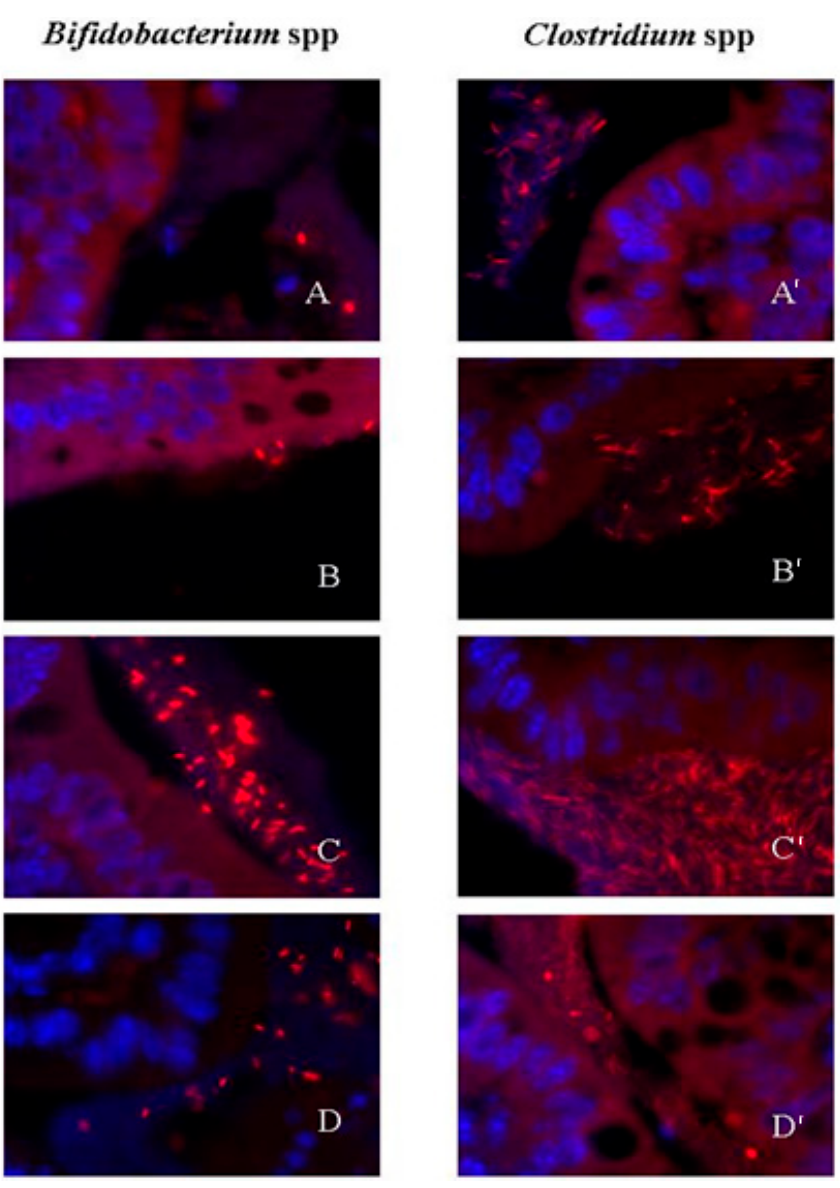
Figure 5. Bacterial wall adherence. Representative images ( × 100) showing bacterial adherence to the colonic epithelium for Bifidobacterium spp. and Clostridium spp. ( A , A’ ) non-adhered bacteria within the intestinal lumen. ( B , B’ ) adhered bacteria in a vehicle-treated mice (7-day), ( C , C’ ) adhered bacteria in a rifaximin-treated mice (50 mg/kg, 7-day); ( D , D’ ) adhered bacteria in a rifaximin-treated mice (150 mg/kg,